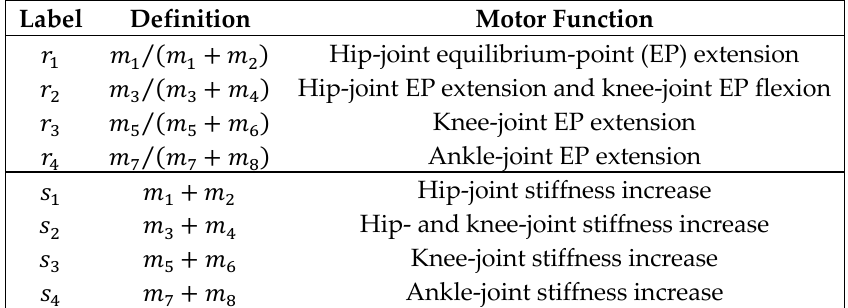
Table 1. Definition of the agonist–antagonist (A–A) ratio and A–A sum (modified from [7]). Label